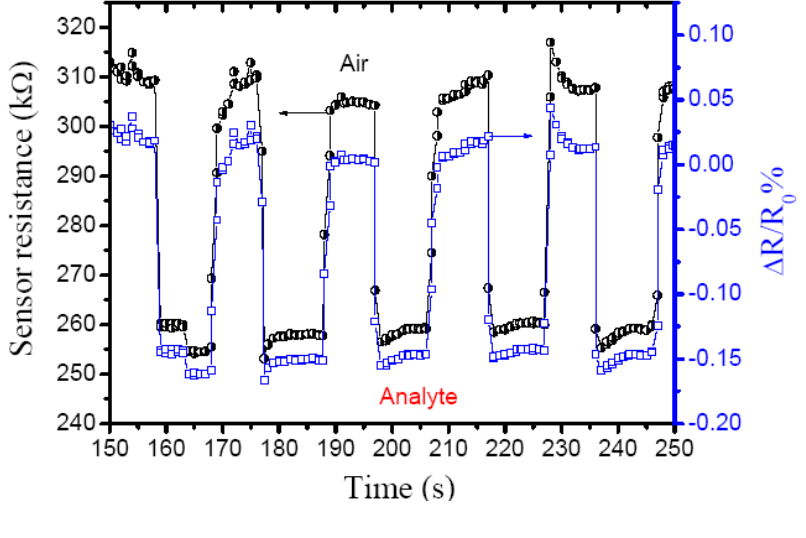
Figure 5. Electric response for Polymers-dye sensor at 26.25 ppm. Ethanol vapor carried with nitrogen gas was turned ON after 158 seconds followed by a reproducible process of resistance change from 303.69 k Ω to 264.48 k Ω with normalized resistance decreasing by 0.15